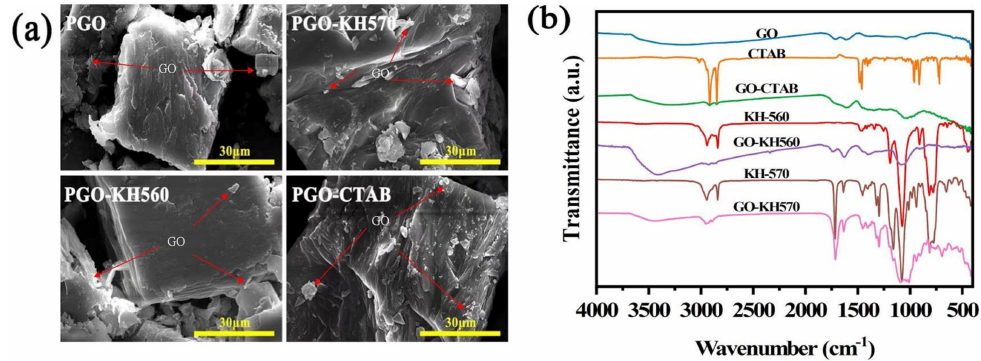
Figure 3. ( a ) SEM images of GO-PEG PCMs, ( b ) FTIR of GO, PEG6000 and GO-PEG PCMs.